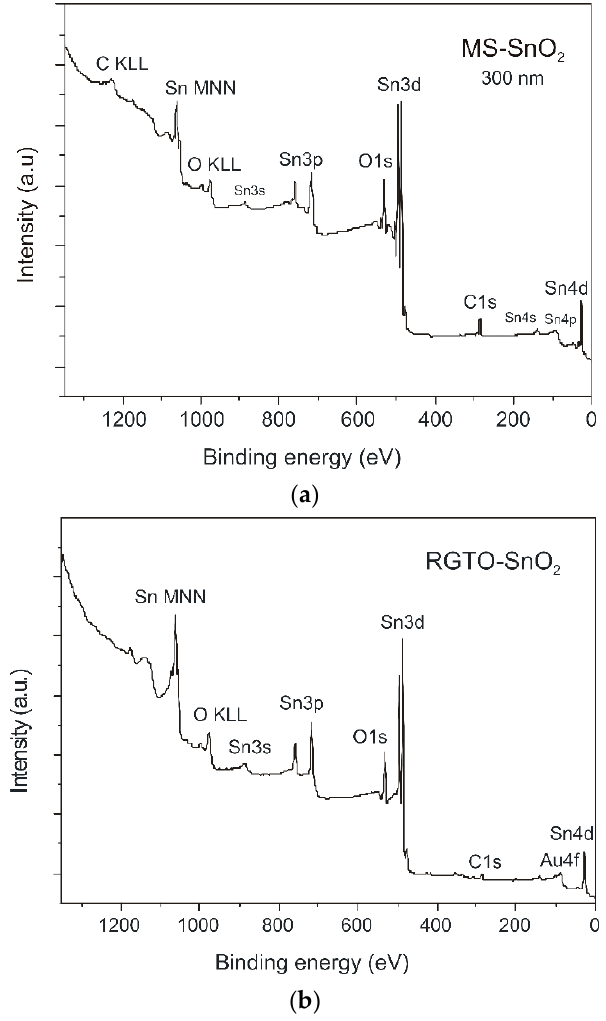
Figure 9. XPS survey spectra of the ( a ) MS-SnO 2 (SnO 2 /SiO 2 ) and ( b ) RGTO-SnO 2 (SnO 2 /Al 2 O 3 ) samples after 360 s ion etching. Table 1. XPS study of the chemical state and chemical composition of the surface of the sensitive layers SnO 2 obtained using (a) magnetron sputtering method and (b) RGTO technique (Sn deposited at 270 ◦ C). Sn3d5 Layer (eV)